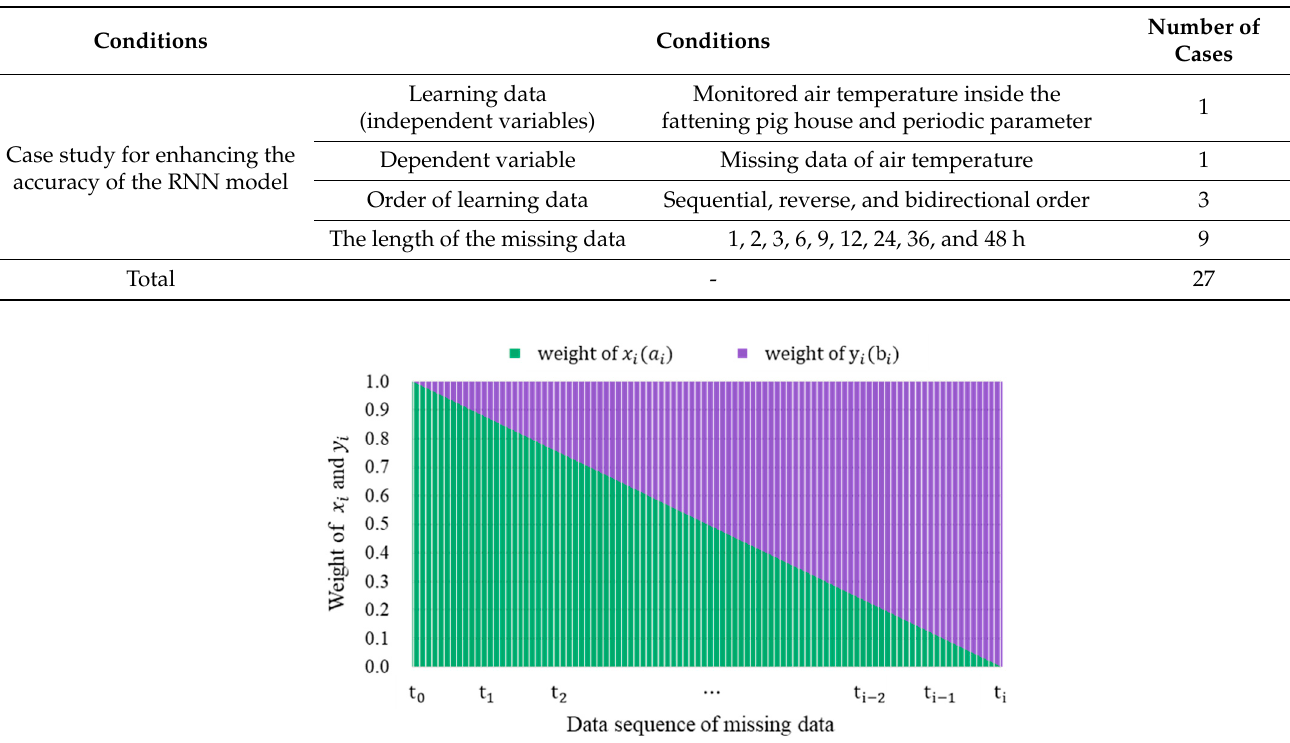
Figure 6. Weight of 𝑥 (cid:3036) and 𝑦 (cid:3036) according to the data sequence of the missing data.